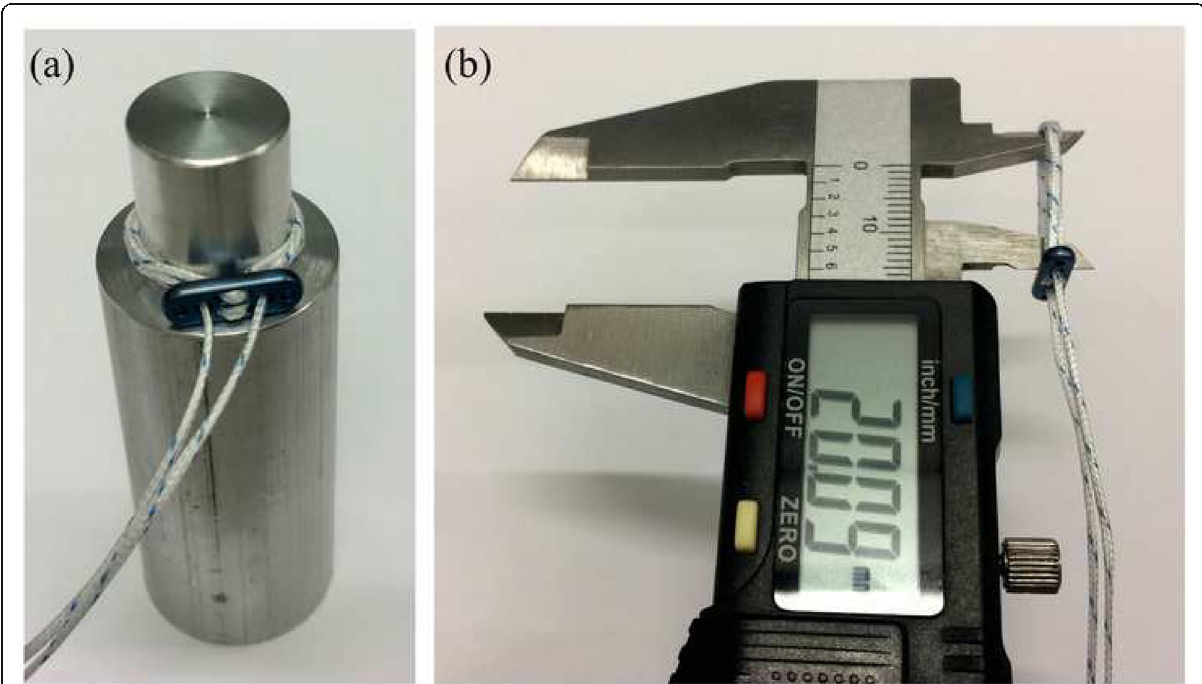
Fig. 2 a Adjustable-loop devices were tightened to match the size of the fixed-loop device using a custom-built 20 mm diameter cylinder, b the size was confirmed using a Vernier